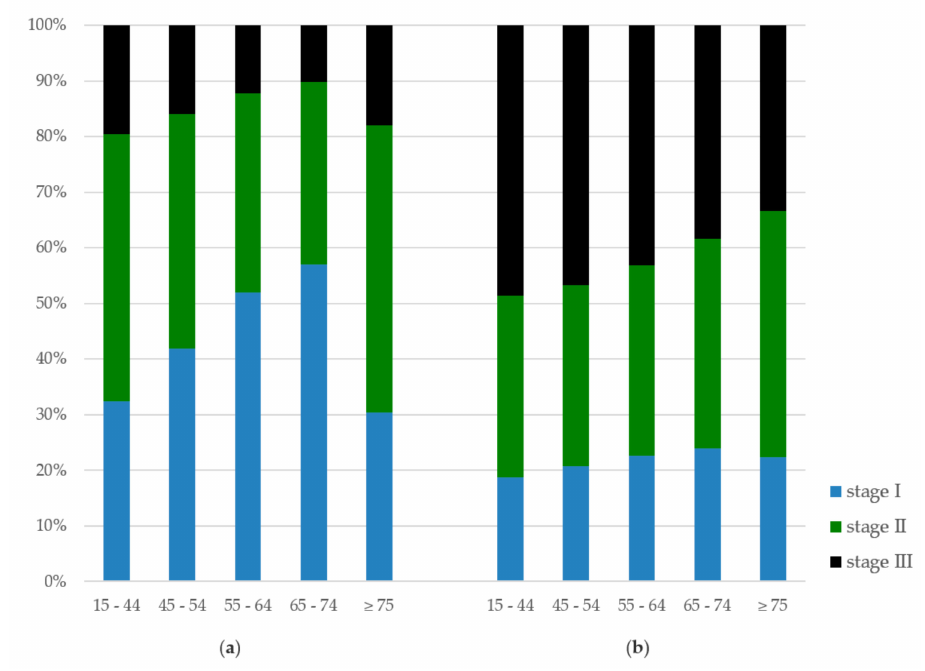
Figure 1. Tumor stage by age at diagnosis: ( a ) breast cancer, and ( b ) colorectal